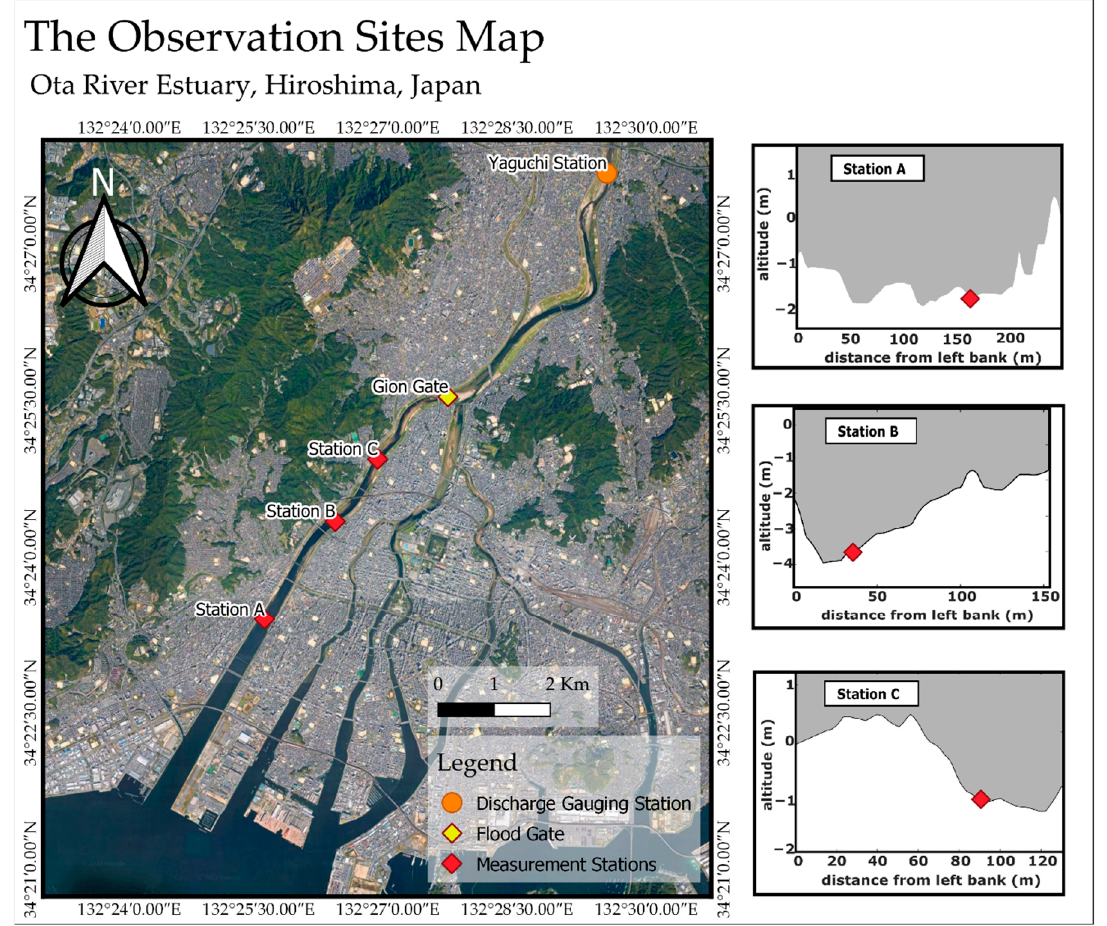
Figure 1. The observation sites in the Ota Diversion Channel, Hiroshima, Japan. Red diamonds show the location of instrument deployment. Insets show a cross-sectional view (seaward) of each station.